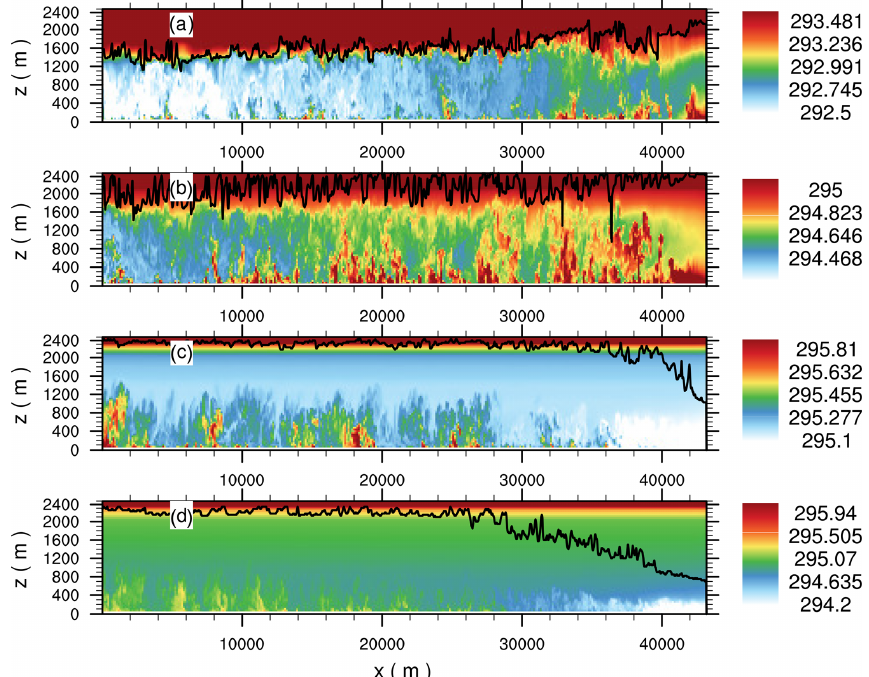
Figure 11. Instantaneous x – z cross-section of the simulated potential temperature (contours) and local boundary-layer height (black solid line) in PALM at (a) 10:00UTC, (b) 13:00UTC, (c) 16:00UTC, and (d) 16:30UTC. The boundary-layer height is calculated according to the Richardson bulk criterion. The inflow boundary is on the right. Please note that the inflow direction is from the south-east, meaning that the x axis does not correspond with the distance to the inflow boundary. The cross-section is taken at y = 32200m (indicated by the dashed black line in Fig. 12b) where the potential temperature is not affected by advection from the southern inflow boundary. Also note the different contour levels and colour bars in each panel, which we set to emphasize the horizontal heterogeneity of the simulated boundary layer at the different times of the